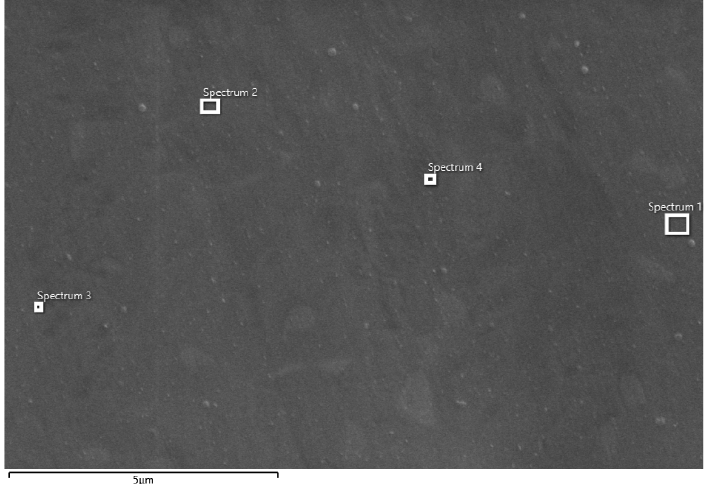
Figure 5. SEM image of Ti-6Al-4V alloy after potentiodynamic polarization measurements in PBS solution with marked spots (position 1–4) of EDS analysis.